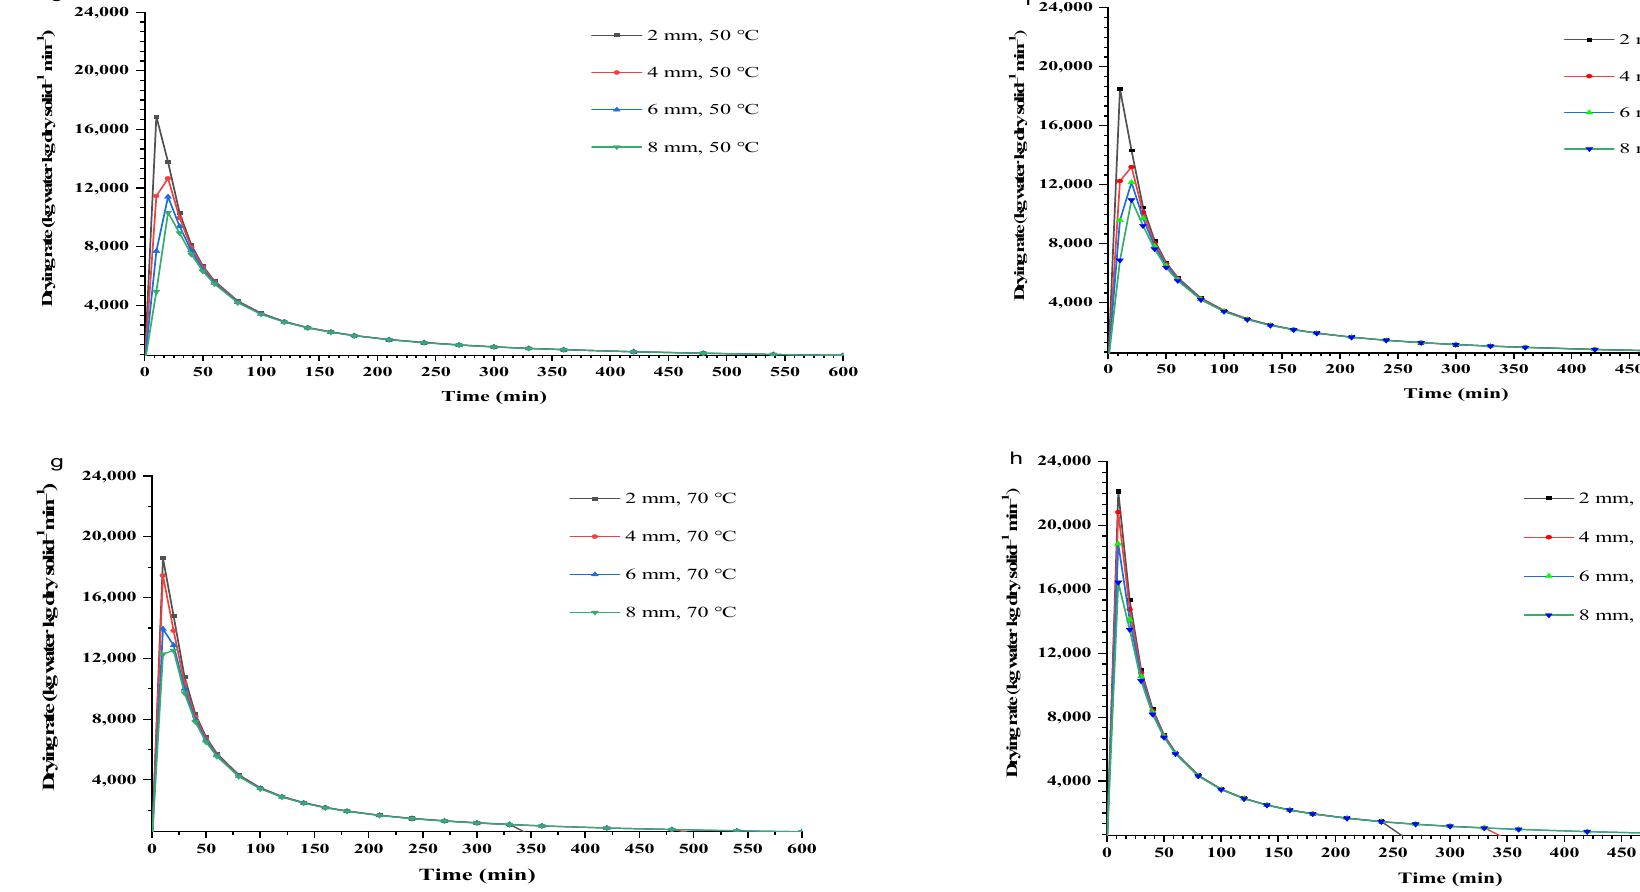
Figure 2. Variation in moisture content vs. drying time ( a – d ) and drying rate vs. drying time ( e – h ) for plantain banana slices.